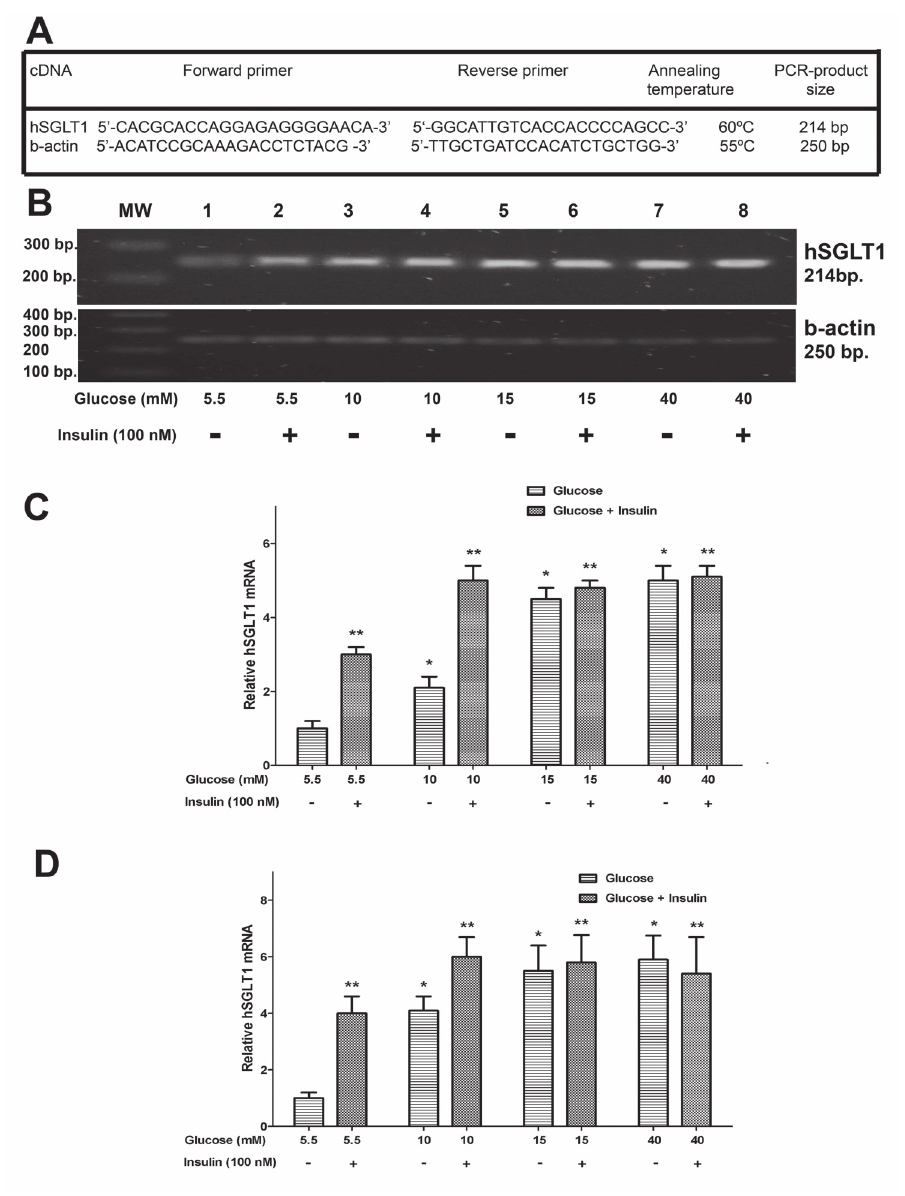
FIGURE 5. Effect of glucose and insulin on hSGLT1 expression in intestinal epithelial cells. (A) Speci fi c primers and annealing temperatures employed in semi-quantitative PCR (RT-PCR). (B) Effect of increasing glucose concentrations and insulin treat- ment on hSGLT1 expression in HT-29 cells. HT-29 cells were treated with increasing concentrations of glucose in the absence or presence of 100 nM insulin for 6 h. The relative amount of product was quanti fi ed by densitometric analysis of DNA bands (C). RTq-PCR (D). Results are mean ± SEM of three independent